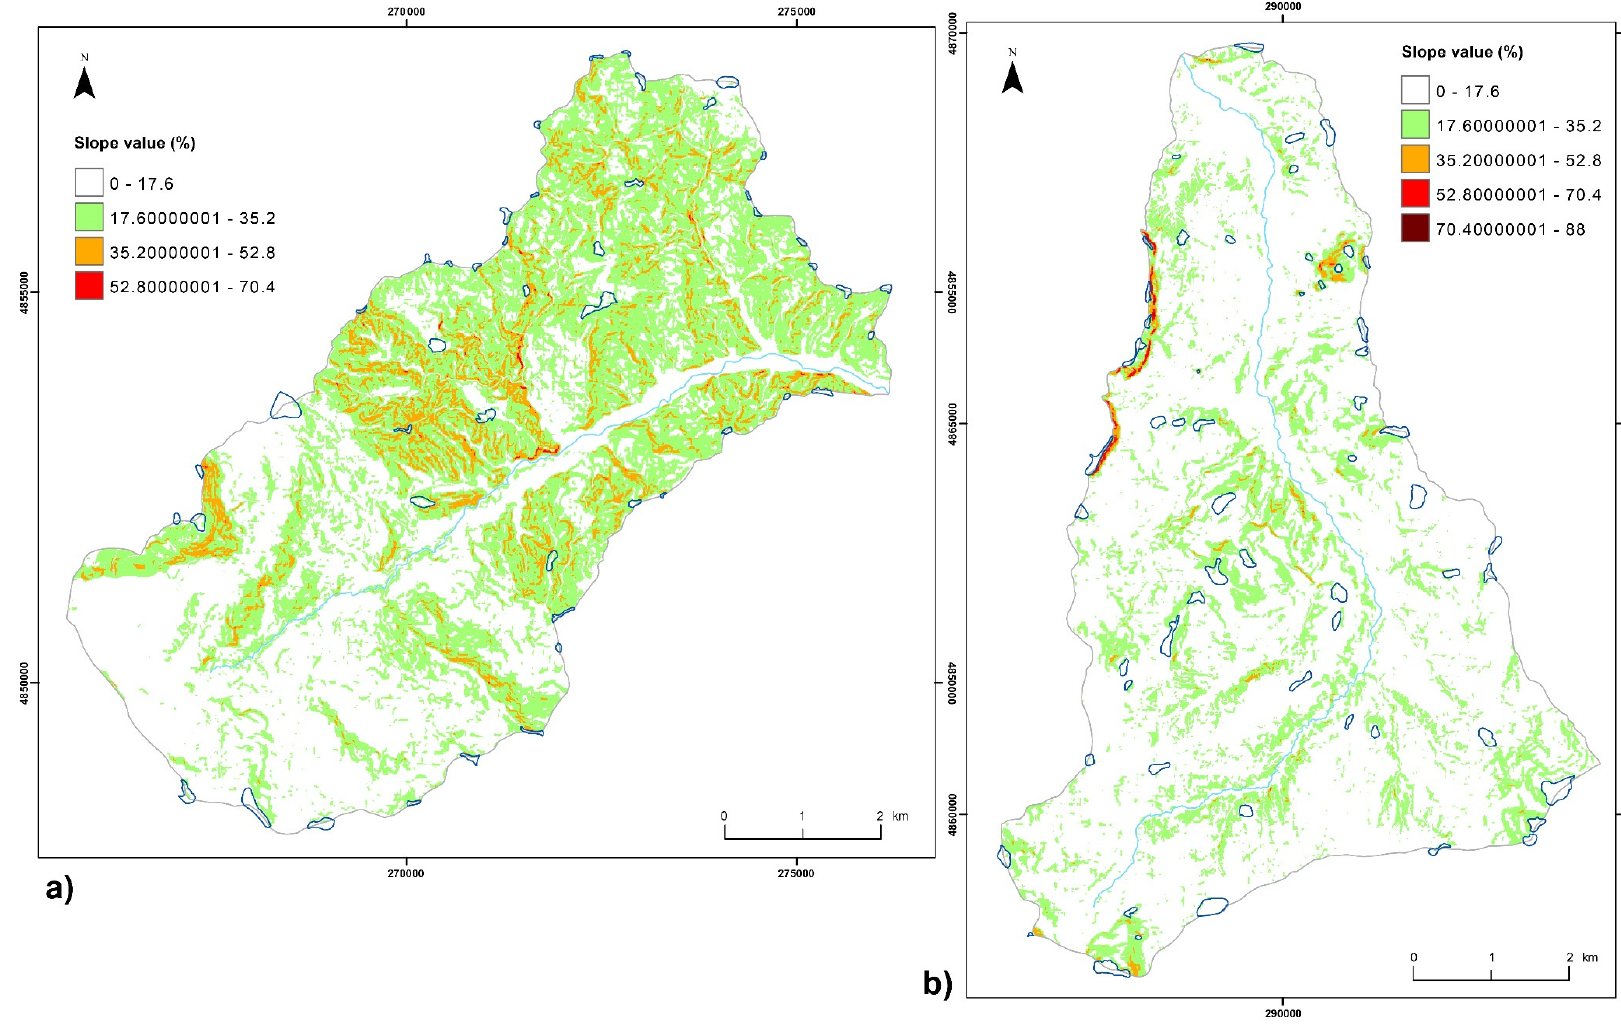
Figure 5. Slope maps of Senatello ( a ) and Mazzocco ( b ) river valleys with evidence of sub-flat erosion surfaces (blue polygons).